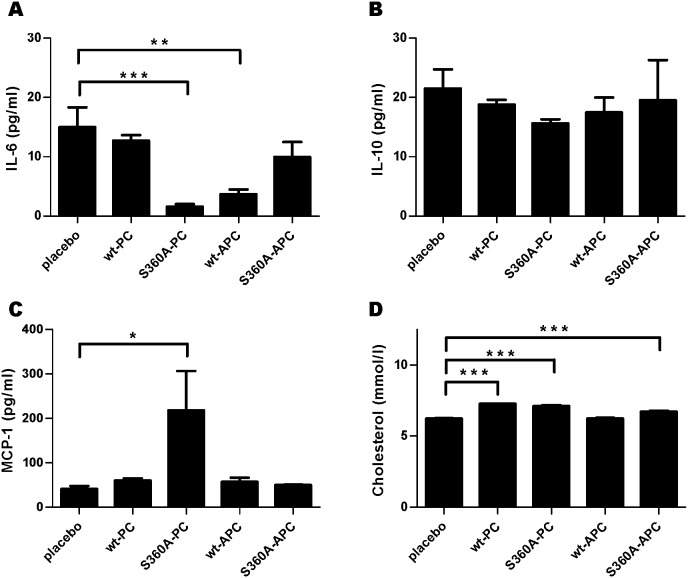
Effects of wt- and S360A-(A)PC treatment on cytokine and cholesterol levels.
A) Interleukin (IL) 6 levels measured with ELISA in mouse plasma pools. B) IL-10 levels measured with ELISA in mouse plasma pools. C) Monocyte chemotactic protein-1 (MCP-1) levels measured with ELISA in mouse plasma pools. D) Cholesterol levels in mouse plasma pools measured with cholesterol CHOD-PAP method. All graphs show mean +/− SEM, statistical significance was tested using one-way analysis of variance with Dunnett post hoc test, *P<0.05, **P<0.01, ***P<0.001.